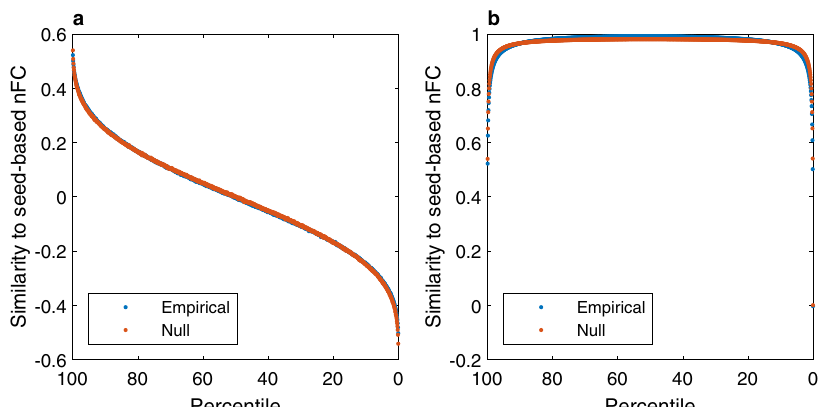
Fig. 6 The static Gaussian null model can explain the spatial similarity between high-amplitude frames based on a seed node and the corresponding correlation map — a core feature of coactivation patterns (CAPs). a For each seed node (i.e. parcel), the frames are sorted in descending order based on the BOLD activity of the seed (horizontal axis). The Pearson correlation is computed between each frame and the seed-based correlation map (i.e., the column of the nFC matrix corresponding to the seed). The curves represent the average similarity over all 200 seed nodes and over 100 HCP subjects. As predicted analytically, the similarity is proportional to the BOLD activity and it decreases as lower-amplitude frames are considered (lower percentiles). The null model is in excellent agreement with the empirical results. b Same as in panel ( a ), but the BOLD activity of all the frames above a given threshold (percentile) are averaged before computing the correlation with the seed-based FC map. Only a small fraction of high-amplitude frames is required to explain most of the nFC variance, reproducing a well-known result in the CAPs literature 12